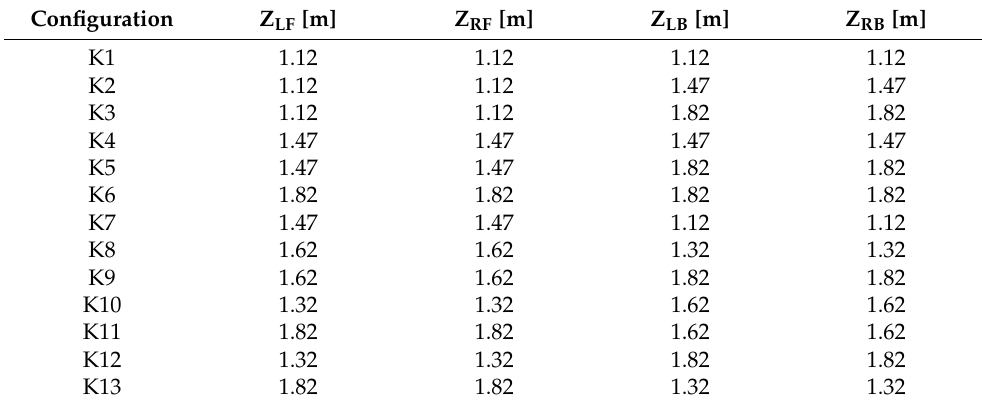
Table 1. Anchor vertical placement in the UGV’s coordinate system.